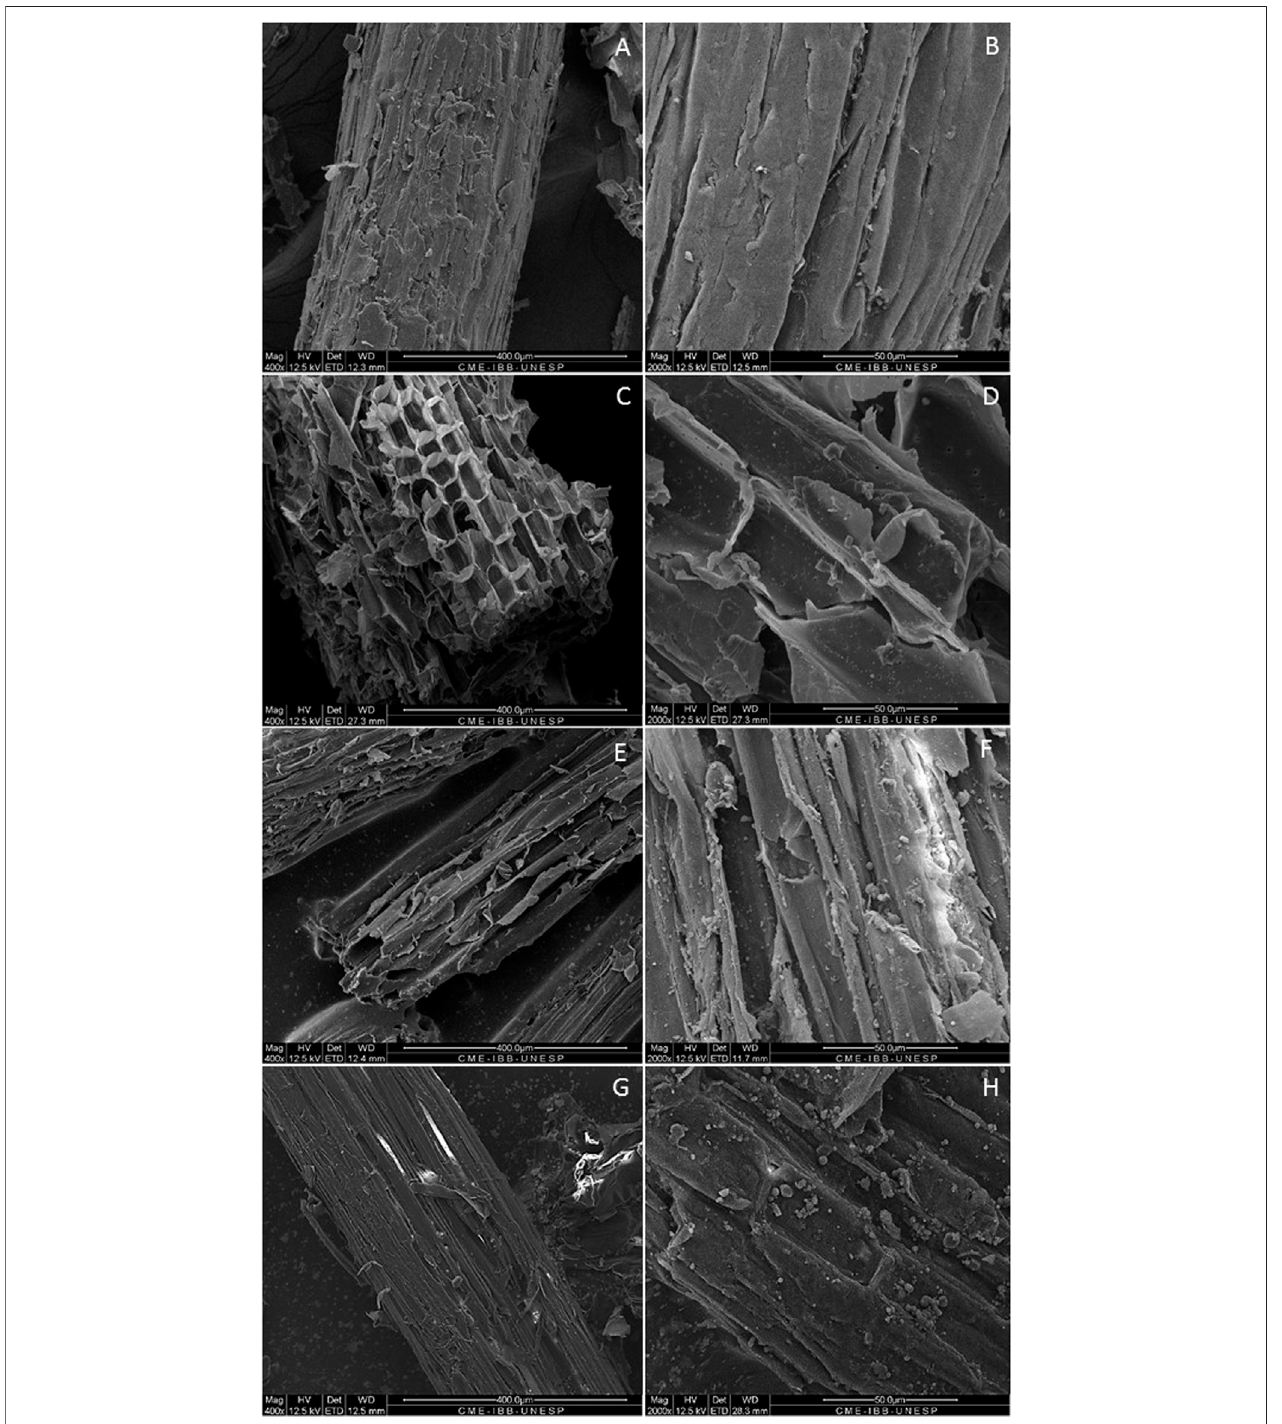
FIGURE 3 | Scanning electron microscopy of untreated bagasse (A,B) , ozone-treated bagasse (C,D) , LHW-treated bagasse (E,F) , and combined pretreatment ozone + LHW (G,H) .